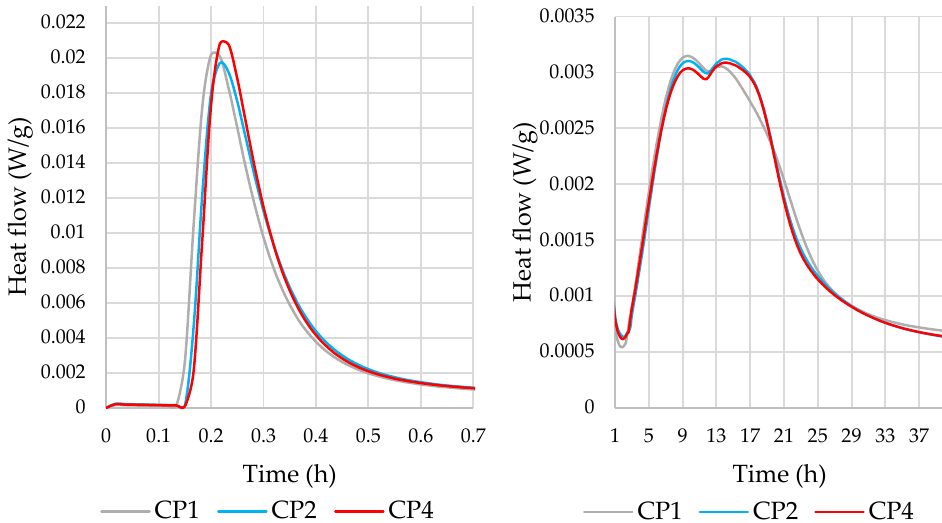
Figure 7. Effect of cement paste composition on the heat flow rate. Figure 7. E ff ect of cement paste composition on the heat fl ow rate.